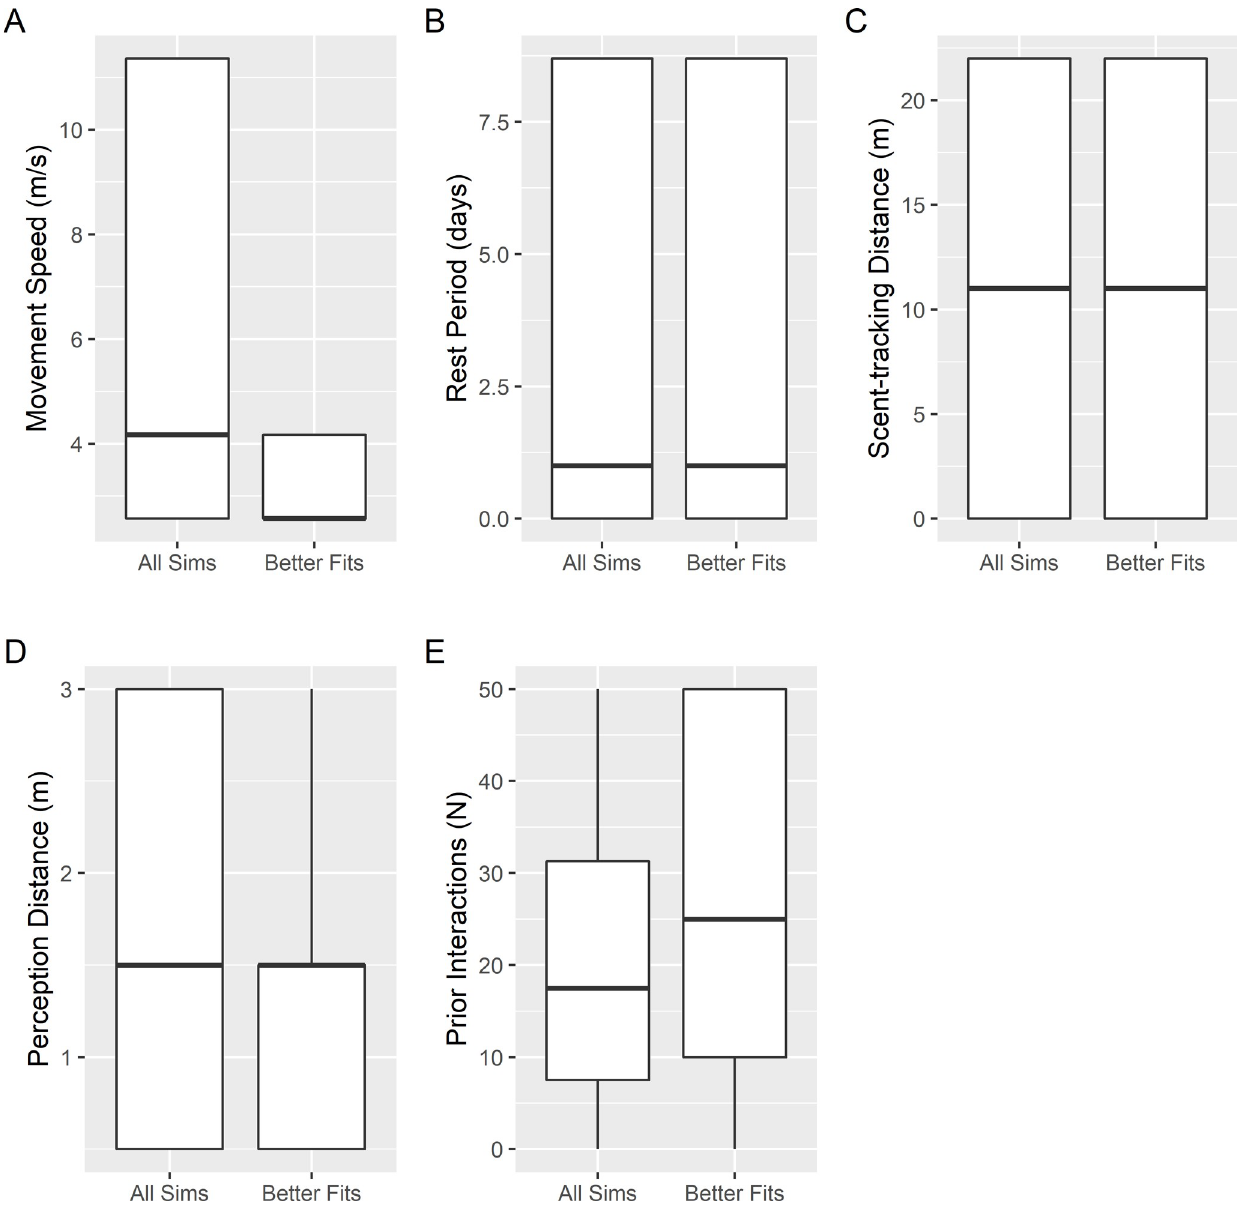
Fig 3. Simulation parameters resulting in superior model fits to empirical observations. Boxplots showing distribution of mechanistic simulation parameters across all simulations compared to distribution of parameters for simulations resulting in superior fits to empirical observations by Stoner & Ray-Culp [32] and Delgado & Glazer [38] as compared to logistic regression dose-response functions fit to the same data. trends in this relationship but underestimated the variability in spawning rates relative to the percent of adults mating when compared to censored (excluding observations of non-zero spawning at zero mating) combined empirical observations [32, 38]. Asymptotic regression functions with lower limit at 0 fit to censored empirical observations similarly underestimated overall variability in this relationship (Fig 5: red line; [32, 38]). Model fits for both functions are provided in Table 4.